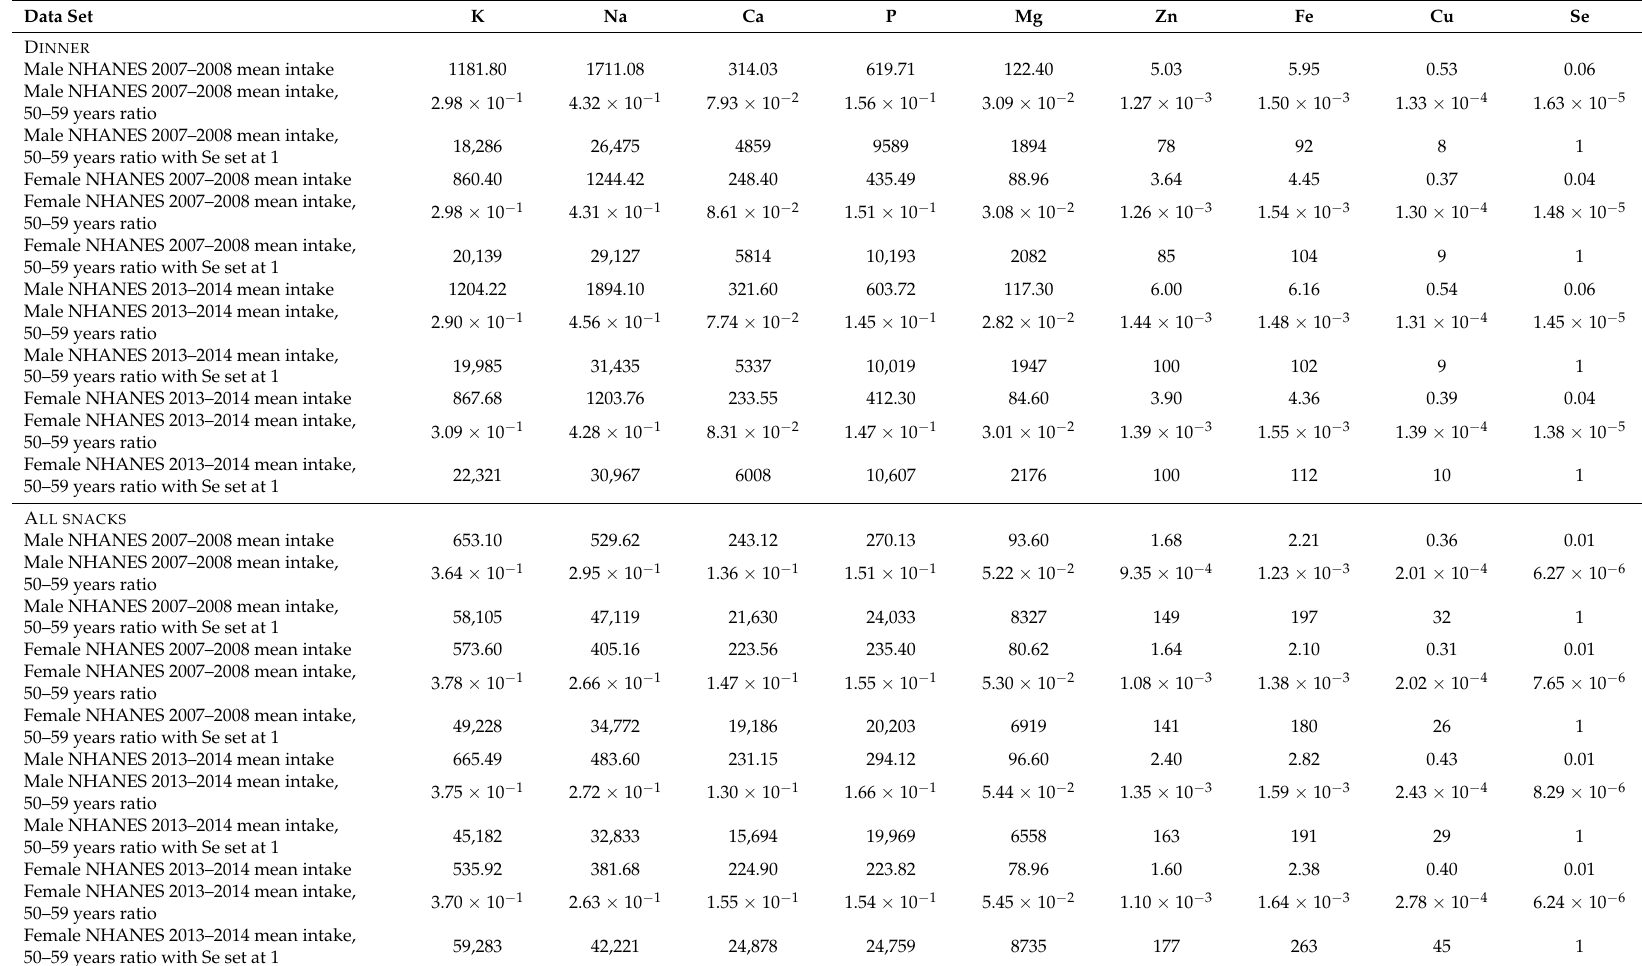
Values are rounded. Abbreviations: calcium (Ca), phosphorus (P), magnesium (Mg), iron (Fe), zinc (Zn), copper (Cu), selenium (Se), potassium (K) and sodium